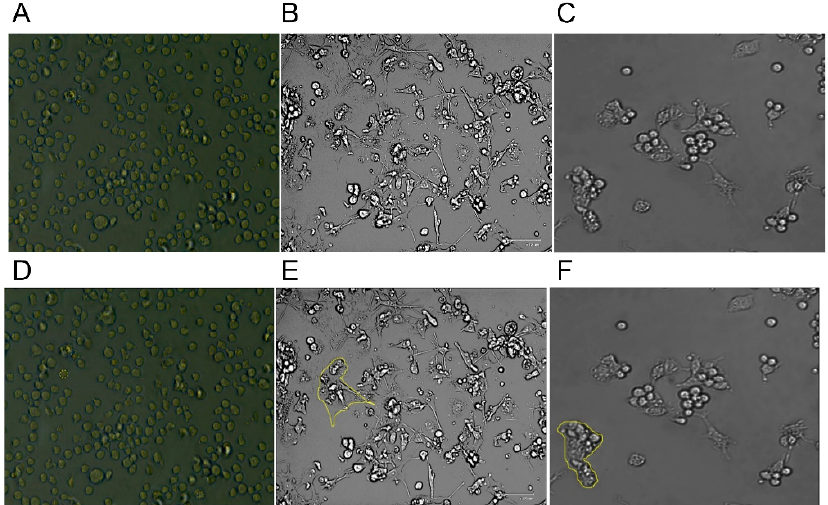
Figure 4. ( A ) THP-1 Immune cells before differentiation. THP-1 was first cultured in RPMI-1640 media, then differentiated into DCs and MACs. Human monocytic THP-1 cell line (ATCC, Manassas, VA, USA)35 were cultured in RPMI-1640 media supplemented with 10% fetal bovine serum (FBS), 1% sodium pyruvate, 0.01% of mercaptoethanol, and 1% penicillin/streptomycin at 37 °C, 5% CO 2 , and 95% humidity. ( B ) DCs and ( C ) MACs after differentiation, respectively. DCs were differentiated based on the Berges et al. protocol. To induce differentiation rhIL-4 (200 ng = 3000 IU/mL) and rhGM-CSF (100 ng/mL = 1500 IU/mL), rhTNF- α (20 ng/mL = 2000 IU/mL), and 200 ng/mL ionomycin were added to the FBS-free media. For the macrophages, the differentiating and activation protocols of THP-1-derived macrophages were adapted and modified from Genin et al. [37]. THP-1 cells were terminally differentiated into uncommitted macrophages (MPMA) with 300 nM phor-bol 12-myristate 13-acetate (PMA; Sigma-Aldrich, Germany) in RPMI 1640 media without FBS supplement. Afterward, cells were activated for 48 h into pro-inflammatory macrophages (MLPS/IFN γ ) by adding 10 pg/mL lipopolysaccharide (LPS; Sigma, USA) and 20 ng/mL IFN γ (Biolegend, San Diego, CA, USA), or into anti-inflammatory macrophages (MIL-4/IL-13) with 20 ng/mL interleukin 4 (IL-4; Bio-legend, USA) and 20 ng/mL interleukin 13 (IL-13; Biolegend, USA). THP-1 cells have a round shape and are suspended in the media, DCs are attached and spread their dendrites in the flask. MACs are also adherent, but without the elongations of the DCs. ( D – F ) show the selection undertaken in ImageJ software for the calculation of the area of the THP-1, DCs, and MACs, respectively.